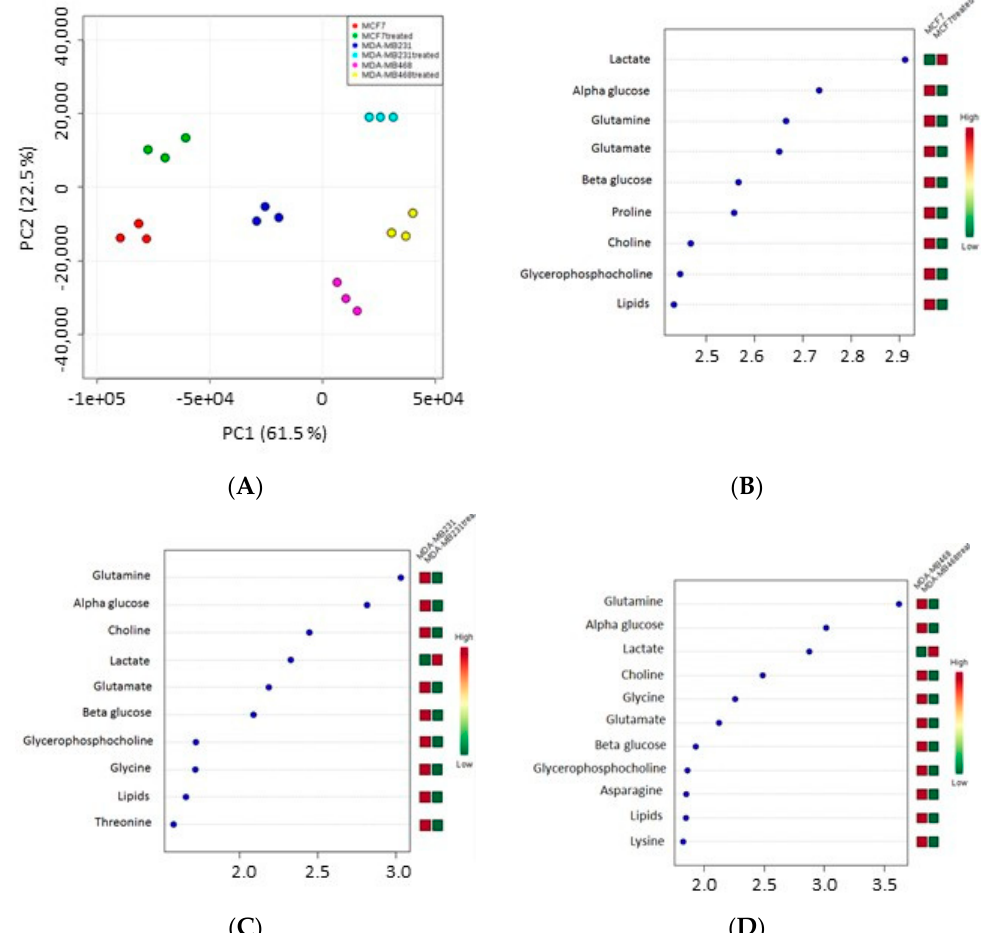
Figure 4. Orthogonal Projections to Latent Structures discriminant analysis (OPLS-DA) plots: ( A ) OPLS-DA and variable importance in projection (VIP) analysis where the metabolites increased or decreased in the endo-metabolome of: ( B ) MCF-7; ( C ) MDA-MB231; and ( D ) MDA-MB468 cells after treatment with the active fraction from the sponge Geodia cydonium , compared to untreated cells.